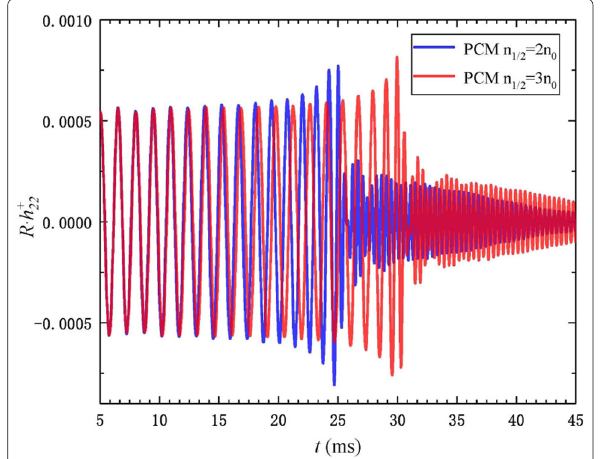
+ The dominant mode of GW strain h multiplied by the 22 distance of the observer to the origin R from BNS merg- ers is plotted in Fig. 13. The plot shows the location of the topology change affecting the number of the inspi- ral orbits, i.e., the number of the peaks in the inspiral phase which is the number of the peaks before merger, defined as the maximum of the amplitude of the GWs. Explicitly, the larger the n 1 / 2 , the more the number of peaks. This could be within the detection ability of the